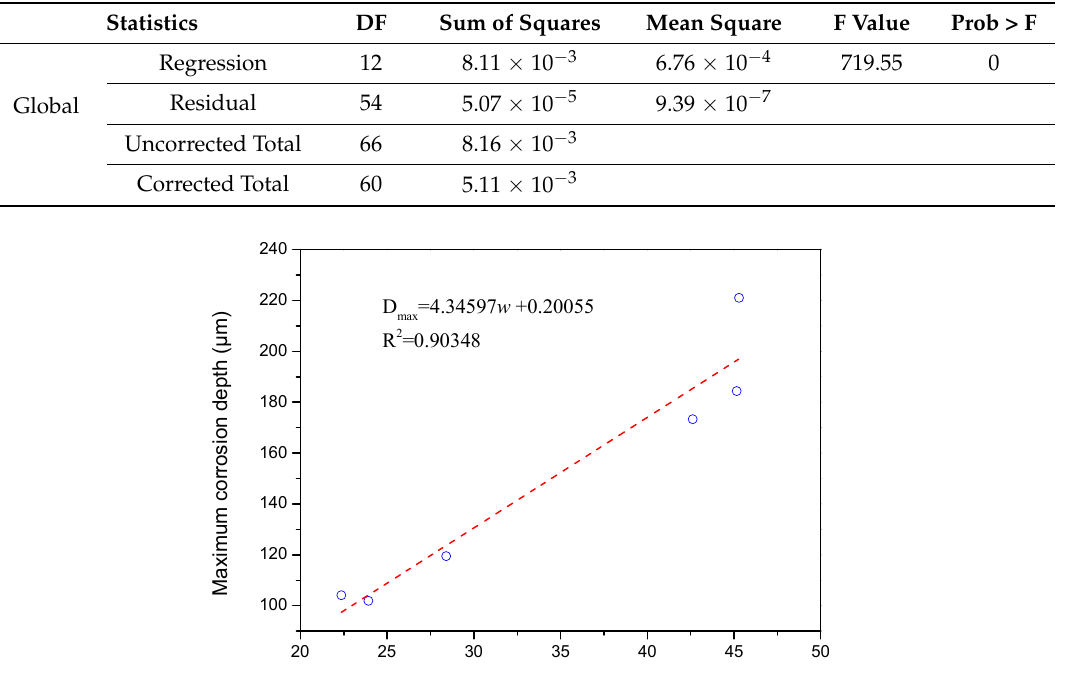
Figure 12. Relationship between the maximum corrosion depth and w.